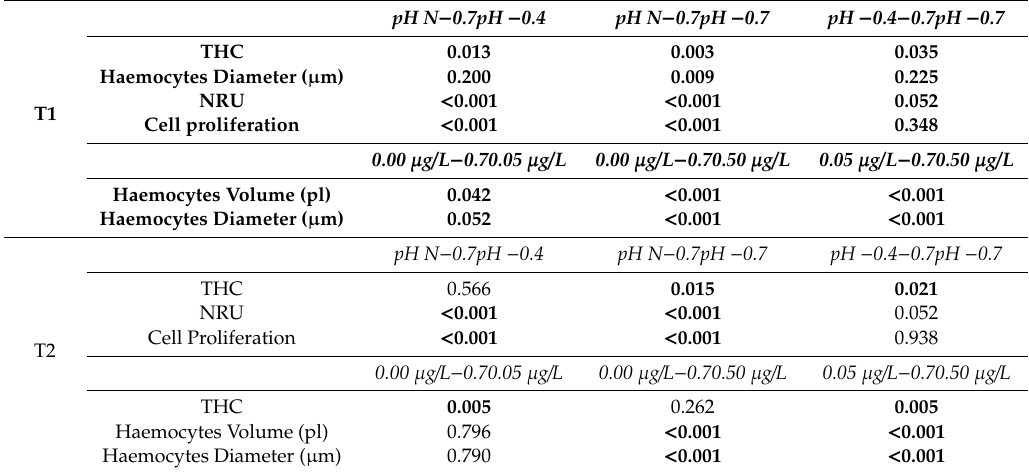
Table 3. Statistical comparisons between experimental groups. Significant results are in bold.